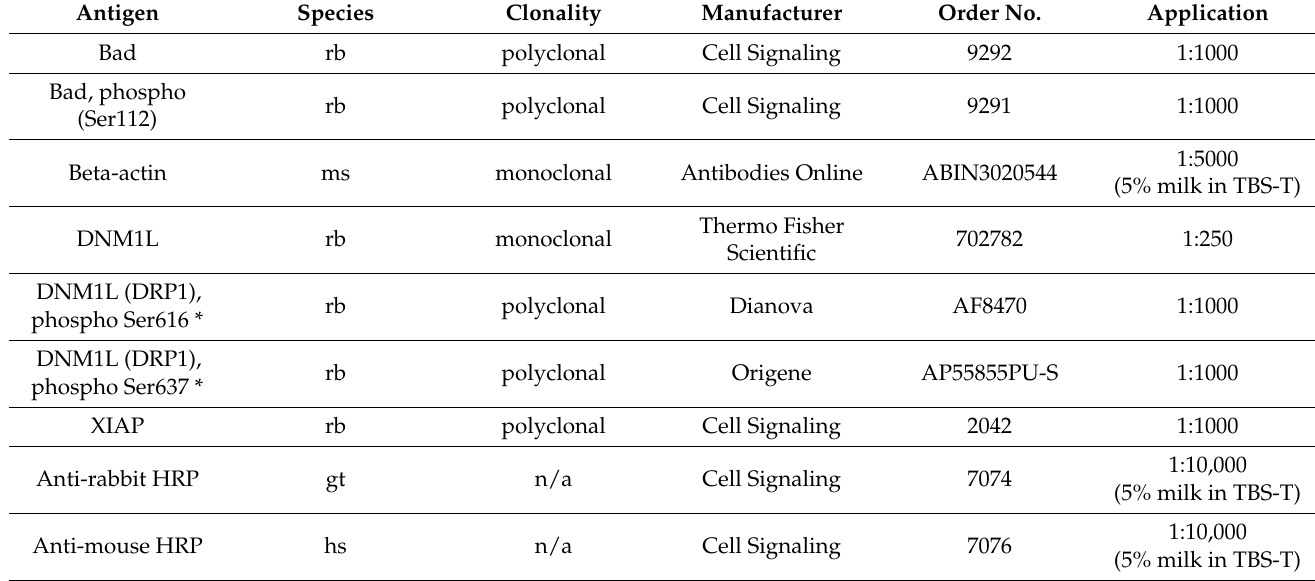
Table 2. List of antibodies used for western blot. The antibodies were diluted, if not stated differently, in 5% BSA and 0.1% NaN3 in TBS-T. Abbreviations: rb = rabbit, ms = mouse. * The phosphorylation sites in the human DNM1L are at positions Ser616 and Ser637. Due to a 100% sequence homology in the BLAST comparison of human with rat DNM1L, we assume that the antibody used also detect the rat-specific phosphorylation sites at Ser635 (Ser616, human) or Ser656 (Ser637, human). Since rat tissue was used in this manuscript, we termed the DNM1L phosphorylation sites according to the rat-specific